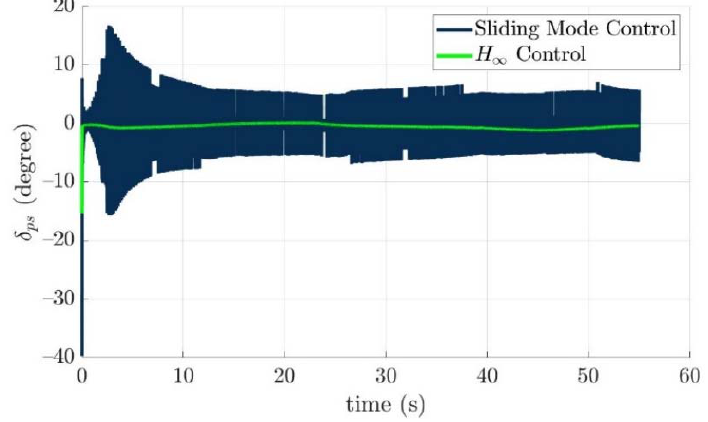
Figure 21. The port stern fin angles of the controlled torpedo-like underwater vehicle for two control